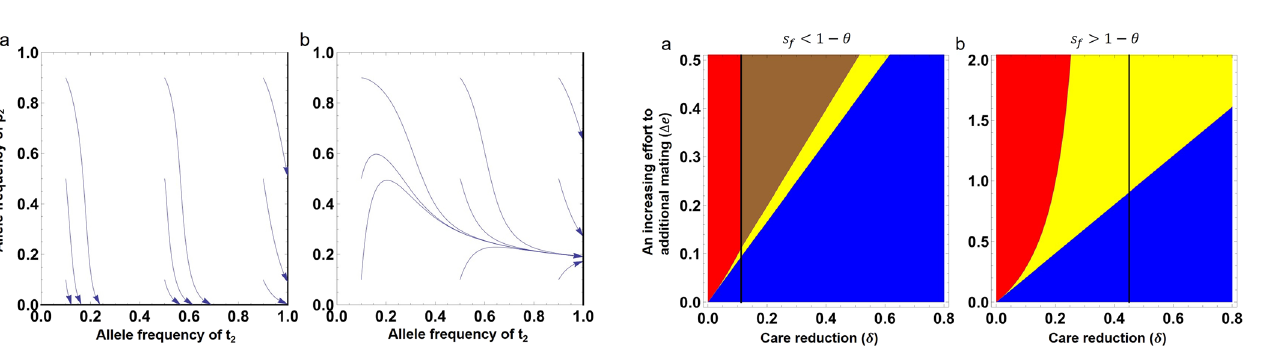
Fig. 3 The conditions required for local stability of different cases of equilibrium when males with a preference trade-off between care investment and seeking additional mating, and the female trait is costly. The equilibria are given in the form of ( p 2 , t 2 , D), where p 2 and t 2 represent the frequency of the allele P 2 and S 2 at each equilibrium, and D represents the corresponding linkage disequilibrium. Regions indicated in blue represent the conditions for local stability of (0, 0, 0). Equilibrium (1, 0, 0) is stable in the red color region. The region indicated in yellow represents